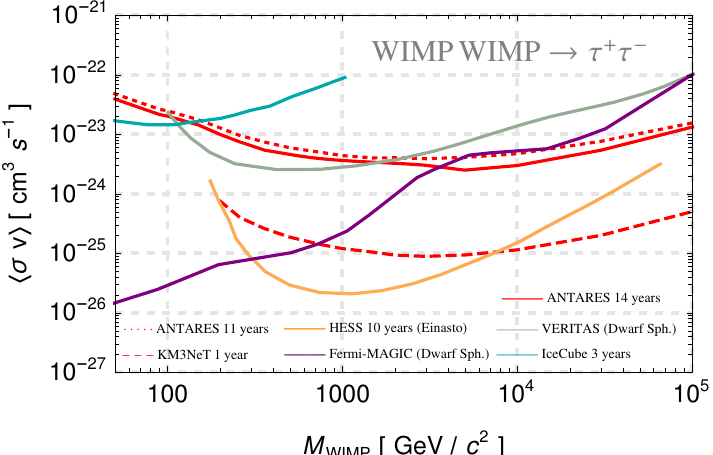
Figure 3. Upper limits at 90% C.L. on the thermally averaged cross-section for WIMP annihilation as a function of the WIMP candidate mass. top Limits from IceCube [38] for several channels; credit: IceCube collaboration; bottom Limits from ANTARES [39] and sensitivity for KM3NeT-ARCA (one year) [40], compared to other results (IceCube 2017 [41], HESS [42], VERITAS [43] and Fermi- LAT+MAGIC [44]) for the τ + τ − channel and using the NFW halo profile [36] unless indicated otherwise. Figure reproduced from [40]; credit: ANTARES and KM3NeT